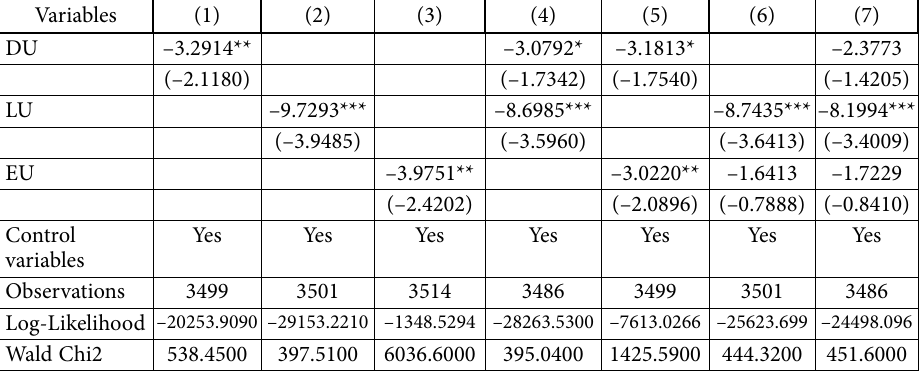
Table 7. Estimation results of SFA models with dependent variable technical